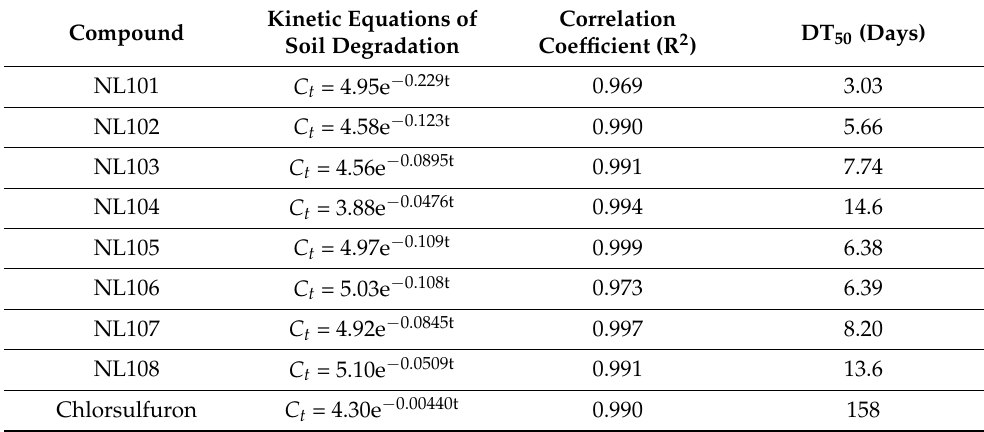
Table 3. Kinetic parameters for alkaline soil (pH 8.39)